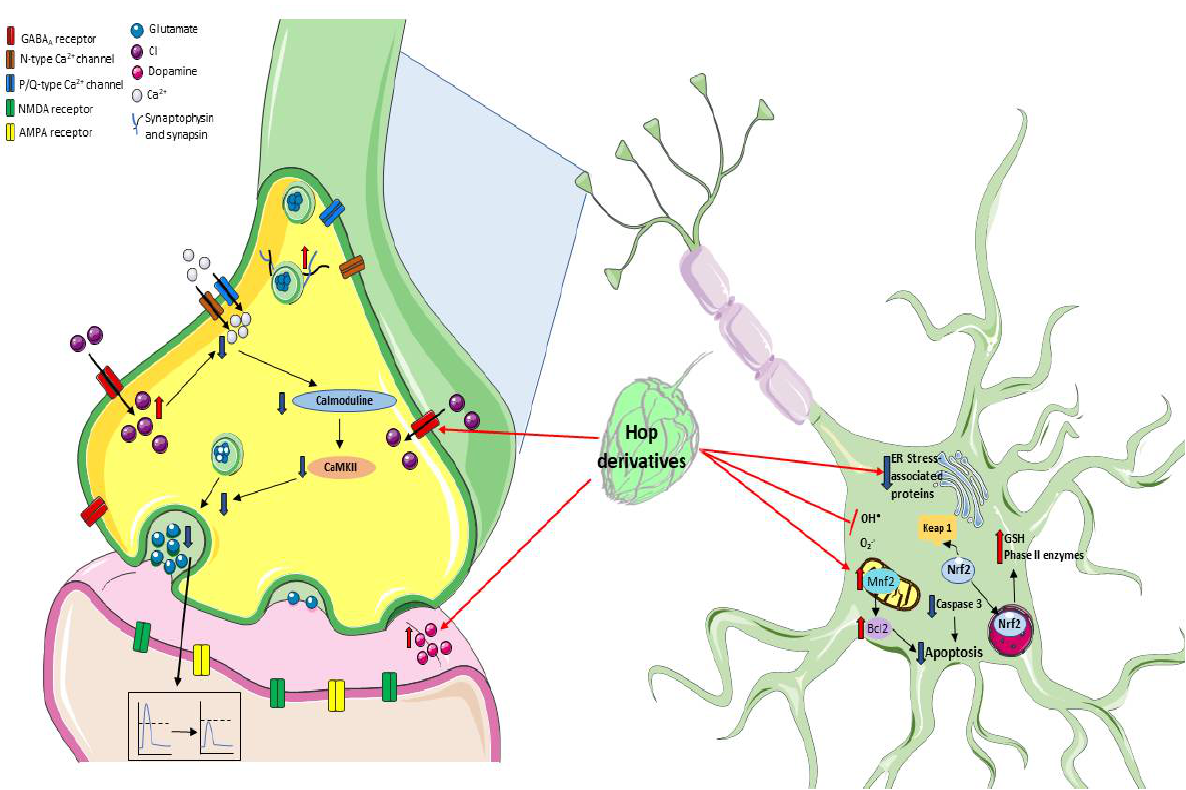
Figure 3. Mechanisms of neuroprotection by prenylflavonoids. It has been described that prenyl flavonoids such as xanthohumol can modulate the GABA A receptors, thus increasing intracellular Cl − concentrations and reducing Ca 2+ influx, leading to a decrease in glutamate release, and preventing an exacerbated excitotoxic neuronal damage. Additionally, hop metabolites can modulate the redox environment through Nrf2 signaling, regulating the expression of mitochondrial proteins, or preventing oxidative damage by directly scavenging